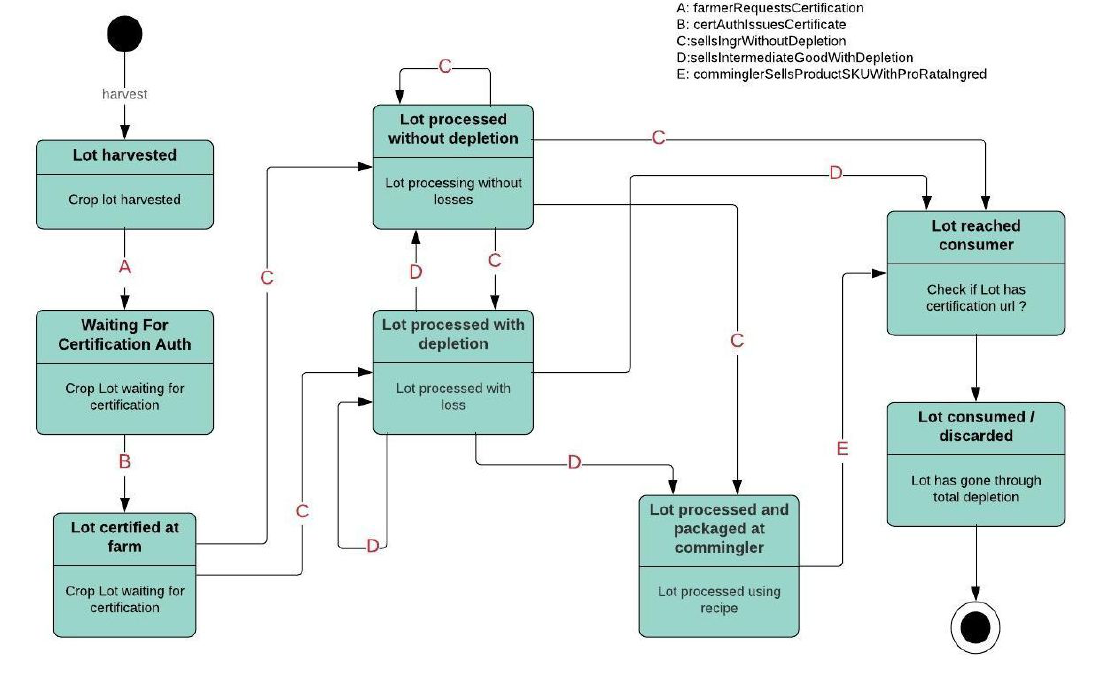
Figure 6. Food Ingredient State Transition